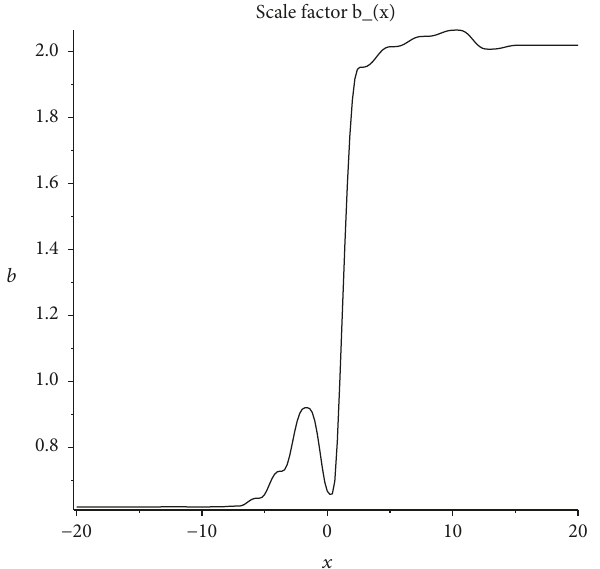
Figure 7: Relation of 𝑏 = 𝑏(𝑥) = 𝑎(𝑥)/𝑎 𝑚 ; 𝑏(1) = 1 is the current value of the scale factor.